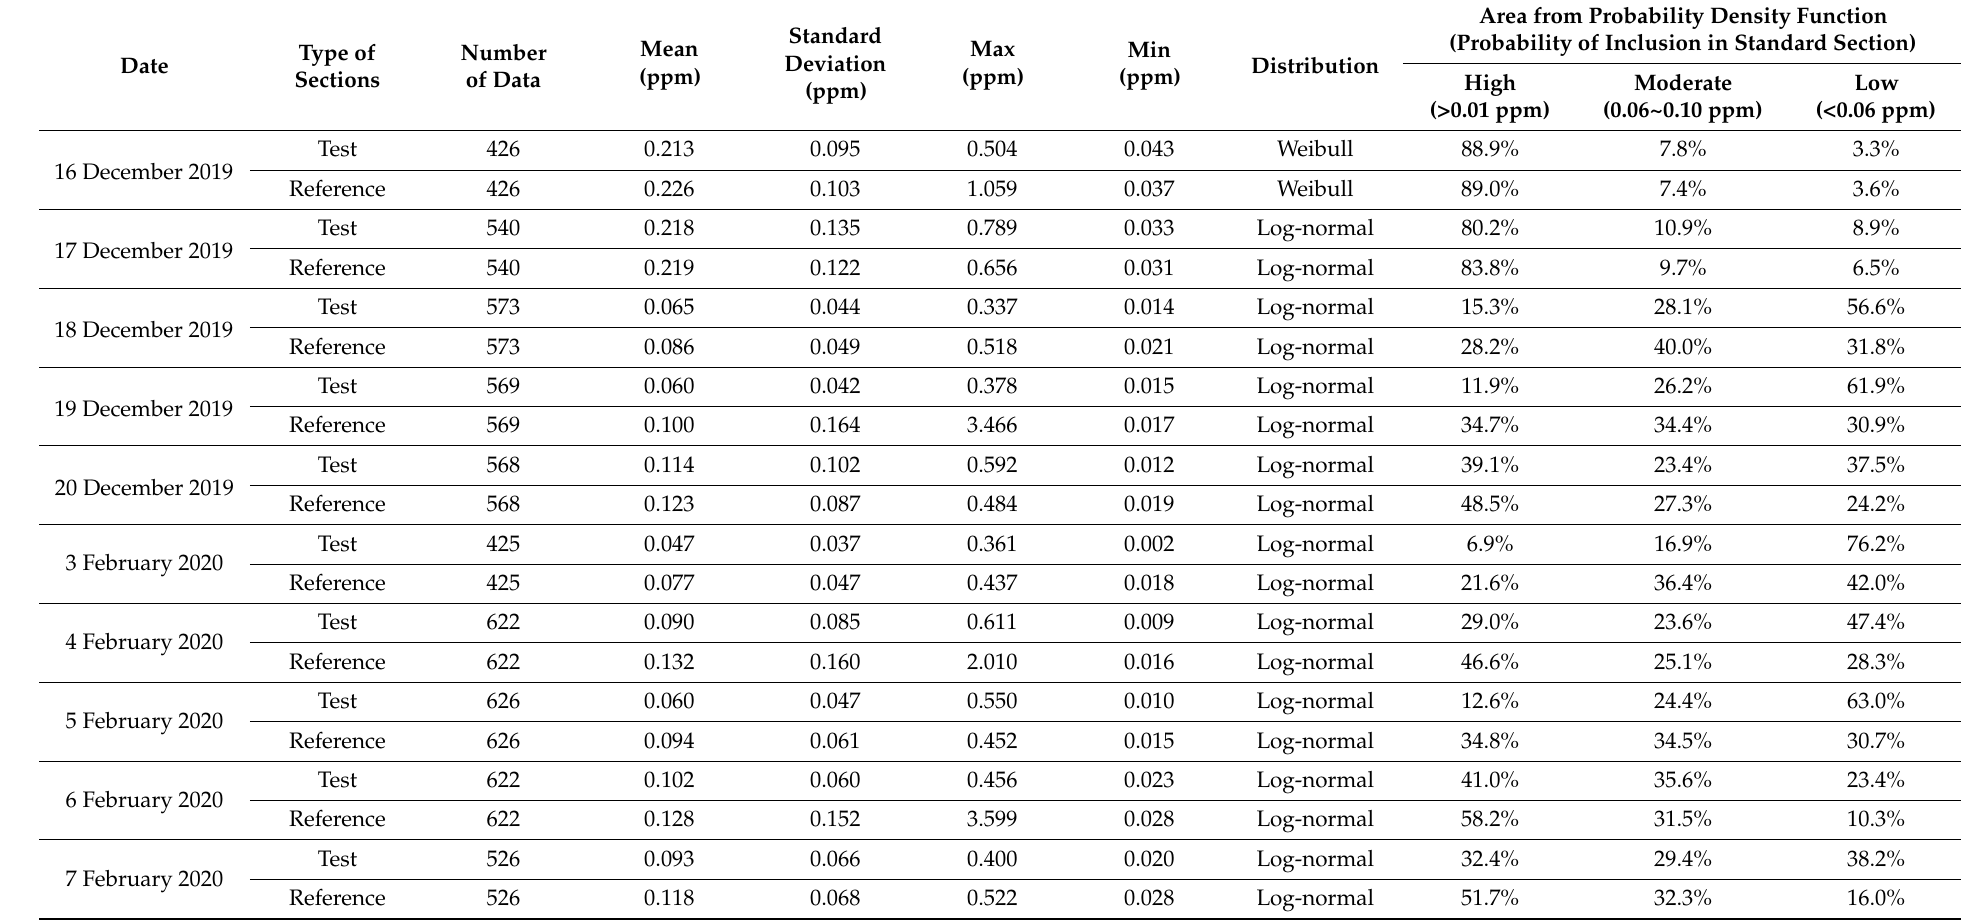
Table 4. Analysis Results of Characteristics of NOx in the Test and Reference